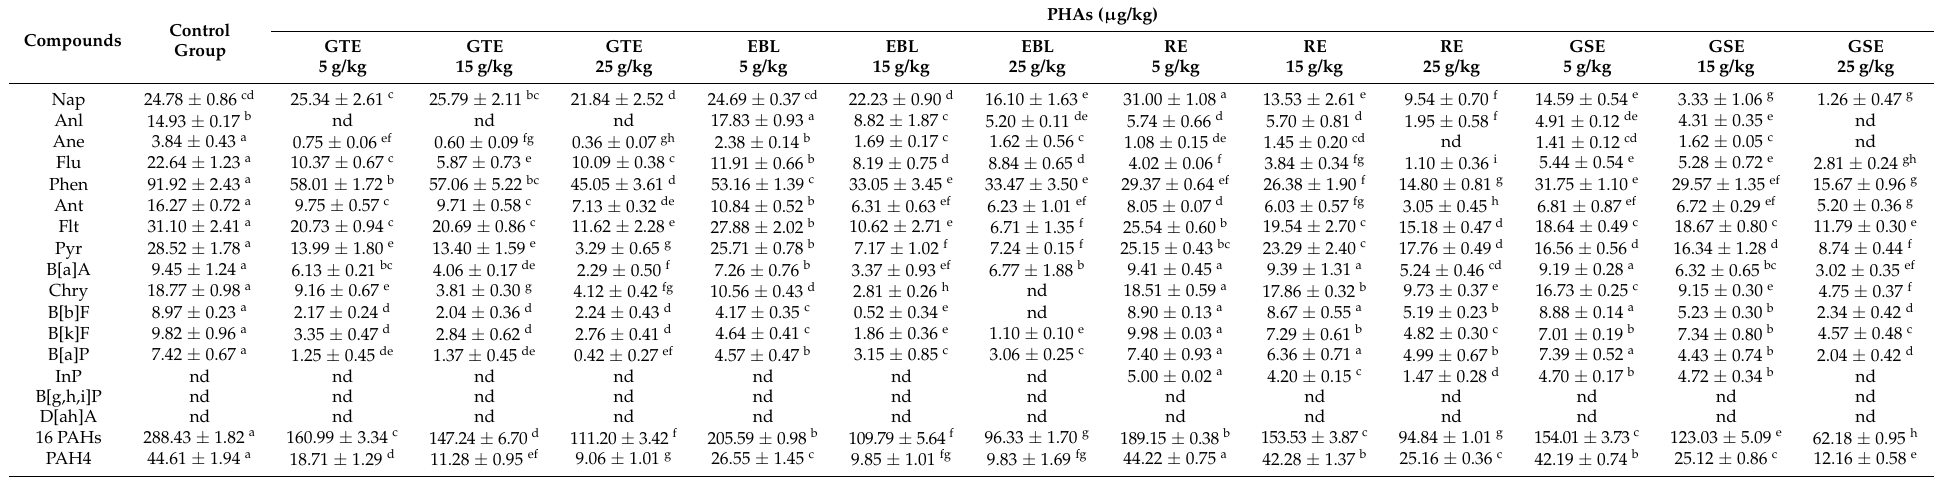
Table 1. PAHs contents of in roast duck skin prepared with four natural